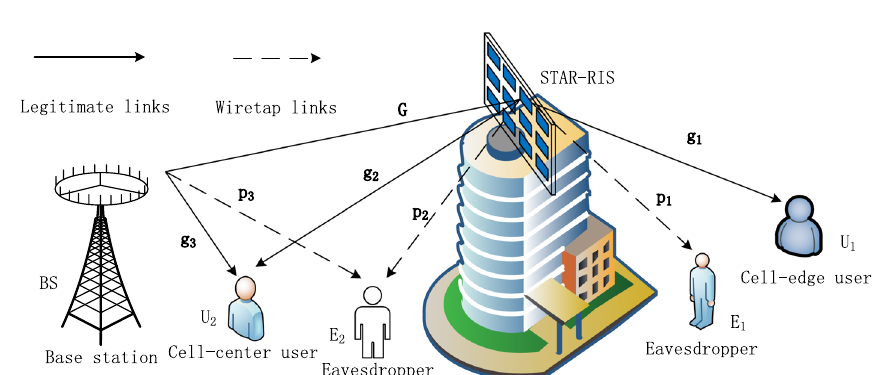
Fig. 1 System model. An illustration of downlink transmission of multi-antenna STAR-RIS-aided NOMA